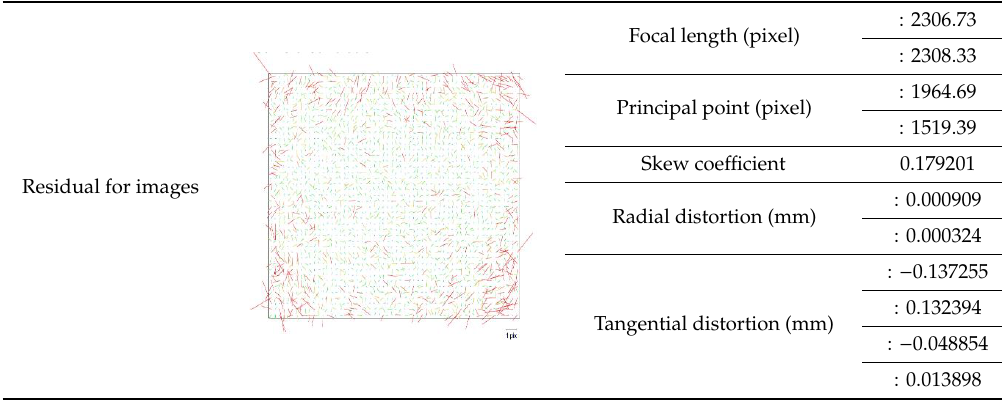
Table 2. Residual for images and interior orientation parameters.